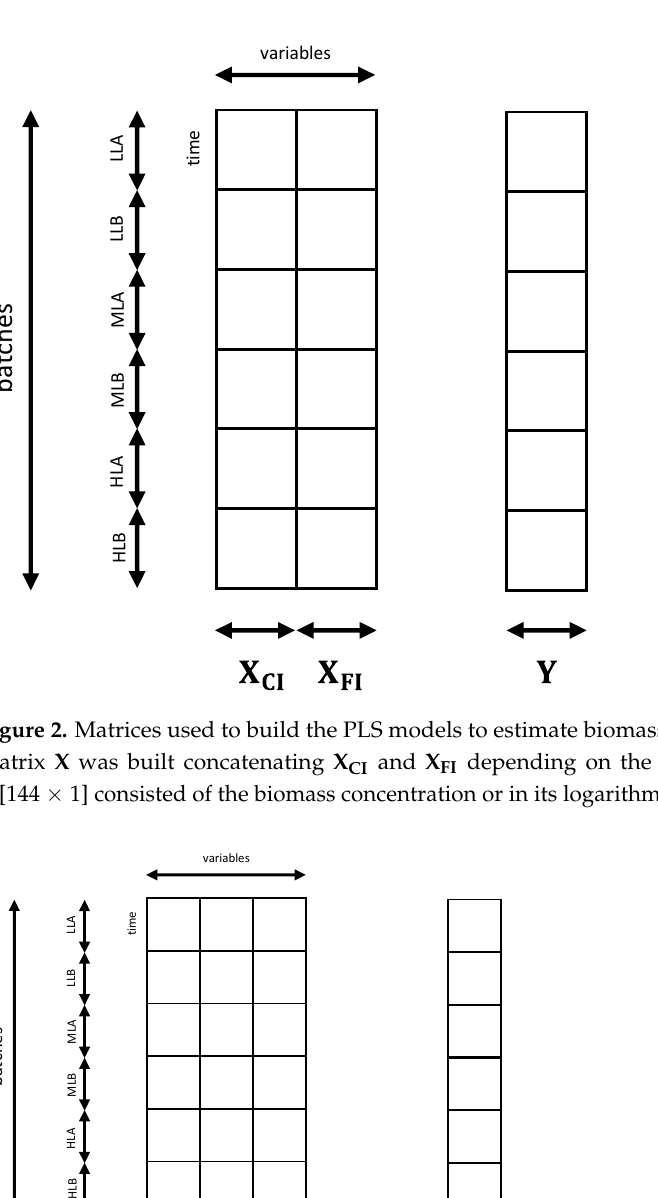
Figure 2. Matrices used to build the PLS models to estimate biomass concentration. The predictor matrix 𝐗 was built concatenating 𝐗 𝐂𝐈 and 𝐗 𝐅𝐈 depending on the model. The response matrix 𝐘 [144 × 1] consisted of the biomass concentration or in its logarithm, depending on the model.